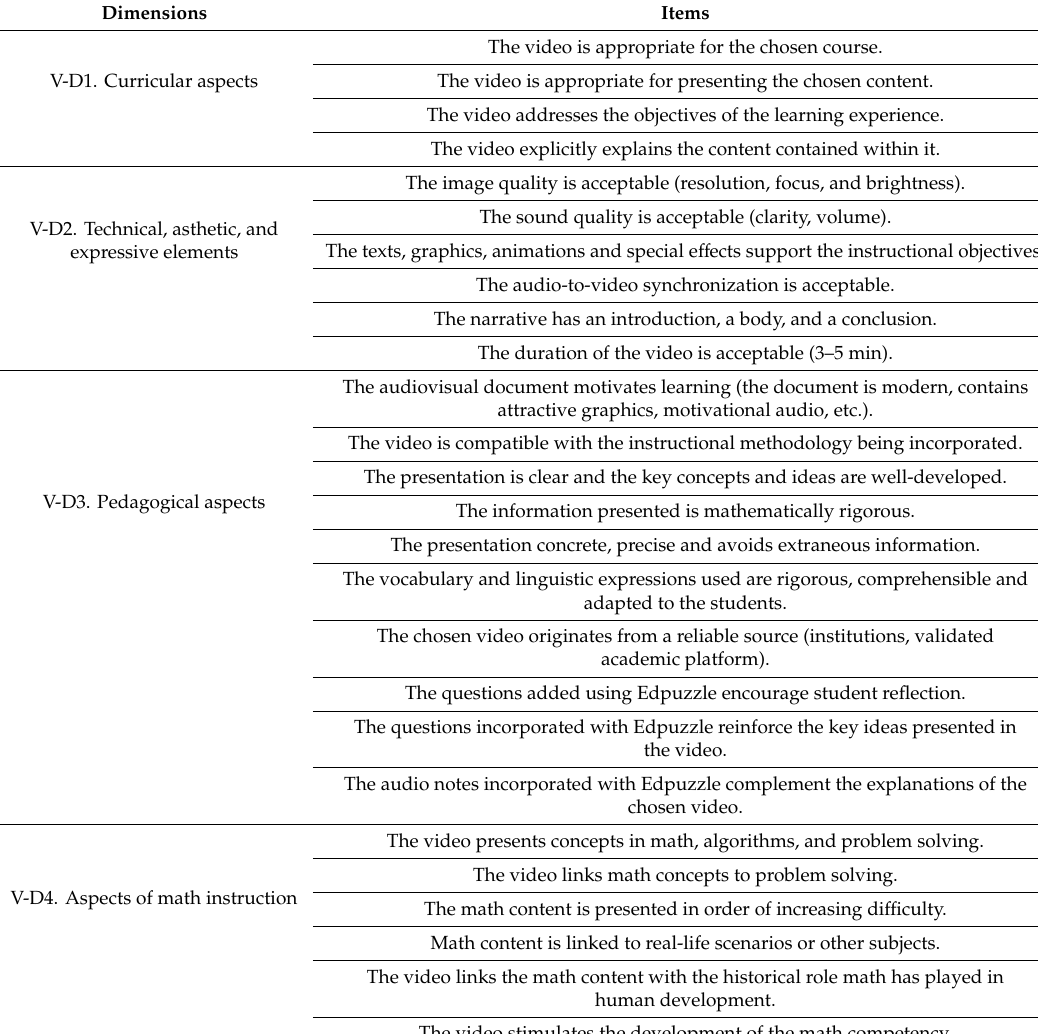
Table A1. Dimensions and items used in the video